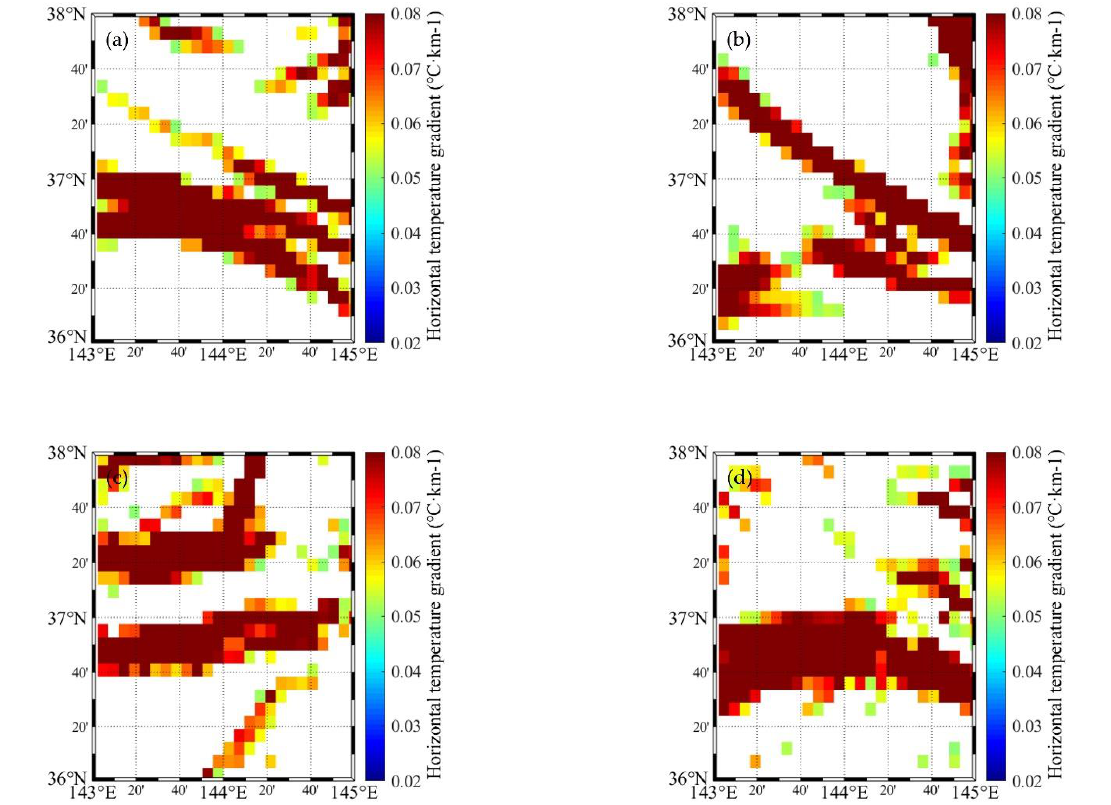
Figure 6. The ocean frontal zone detected by the method of the horizontal temperature gradient (the critical value is 0.05 °C/km): ( a ) 1 January 2019; ( b ) 1 February 2019; ( c ) 1 July 2019; ( d ) 1 August 2019. The detection results of the frontal zone were similar to those of the FCM, especially in winter. However, the continuity of the judgment results of the temperature gradient method is very poor compared with those of FCM, and this discontinuity may become worse due to different judgment standards. Compared with the traditional method of calculating the temperature gradient to detect the frontal zone, FCM is obviously more reliable in our research.